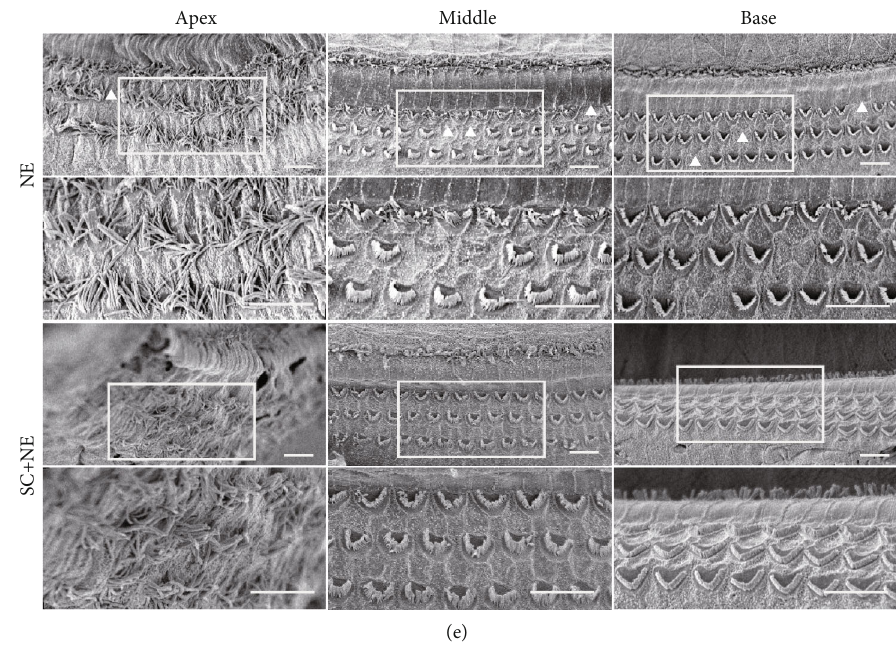
Figure 2: ABR click and tone and basilar membrane and OHC loss. (a) Hearing thresholds of click sound from four groups before and after noise exposure (NE vs. Ctrl: ∗ P < 0 : 01 , SC+NE vs. NE: ∗∗ P < 0 : 01 ; mean ± SEM , n = 6 animals/group). (b) Hearing thresholds of pure tone from four groups after noise exposure (NE vs. Ctrl: ∗ P < 0 : 05 , SC+NE vs. NE: ∗∗ P < 0 : 01 ; mean ± SEM , n = 6 animals/group). Ctrl: control group; SC: sound conditioning group which was exposed to a pure tone of 1kHz at 85dB SPL for 24 hours; NE: noise exposure group which was exposed to white noise at 115 dB SPL for 6 hours per day over 2 consecutive days; SC+NE: sound conditioning and noise exposure group which was exposed to a pure tone of 1 kHz at 85dB SPL for 24 hours, and then 3 hours later, followed by white noise at 115dB SPL for 6 hours per day over 2 consecutive days. Scanning electron micrographs for OHCs in di ff erent turns of basilar membrane from the Ctrl and SC groups (d) as well as the NE and SC+NE groups (e). The lower row pictures are the upper row ones at high magni fi cation. White frames show the enlarged areas; triangular arrows indicate OHC loss. Scale bars represent 10 μ m. Percentage of OHC loss in di ff erent turns from four groups presented in (c) was analyzed with Tukey ’ s multiple comparisons test (Base : ∗ P NE vs. SC+NE < 0 : 05 , Middle : ∗∗ P < 0 : 05 ; mean ± SD , n = 6 pictures from 3 animals/group). Scale is showing frequency and percent distance NE vs. SC+NE from the apex for rat cochlea according to Muller (1991). The apex turn of the basilar membrane was considered as the low-frequency area of 0 to 30 percent distance from the apex for the cochlea; the middle turn was the middle-frequency area of 30 to 60 percent distance from the apex, and the base turn was the high-frequency area of 60 to 100 percent distance from the